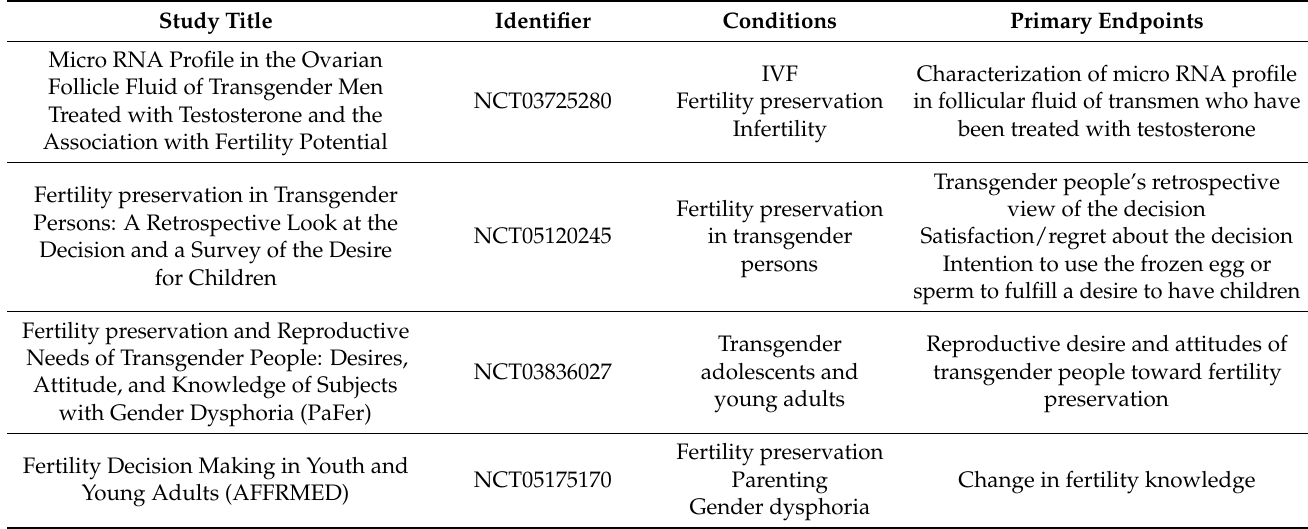
Table 3. Ongoing studies regarding fertility issues of transgender